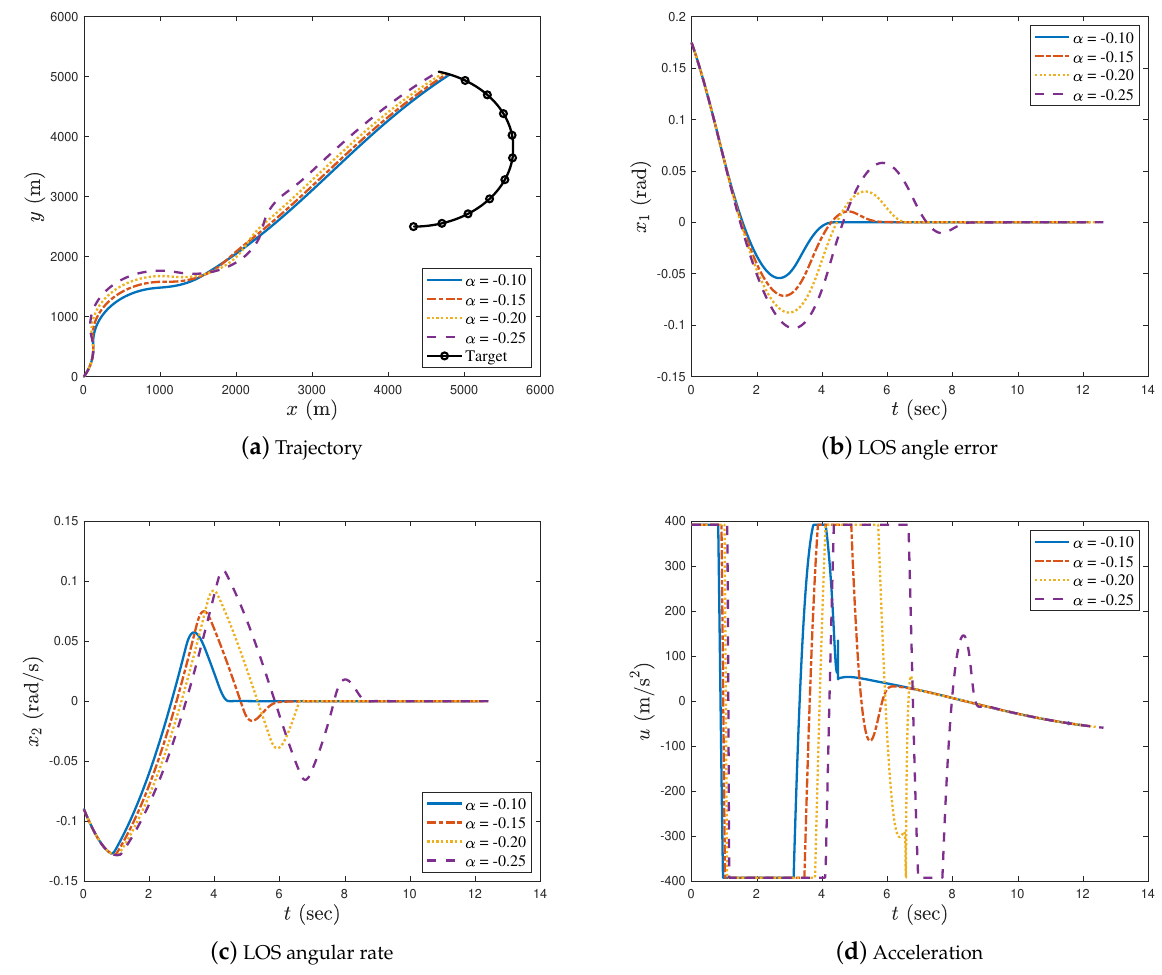
Figure 9. Simulation results with α = − 0.25, − 0.20, − 0.15, − 0.10 in case